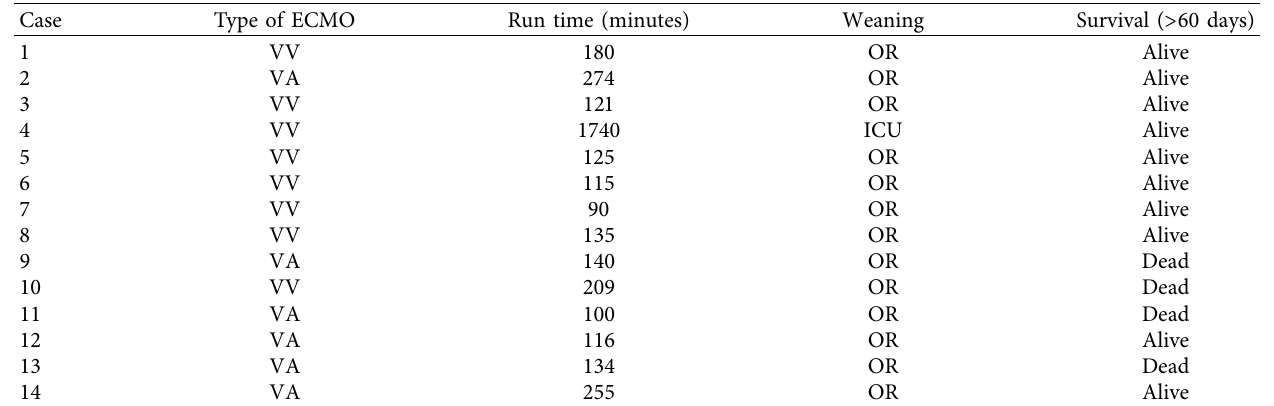
Table 2: ECMO characteristics.